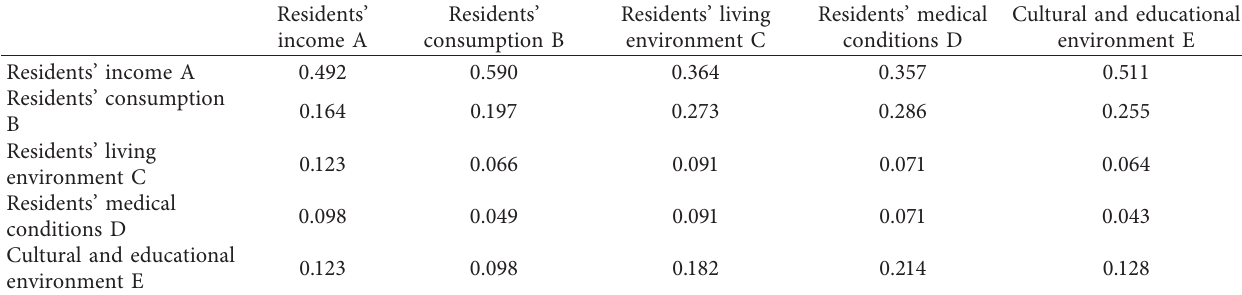
Table 5: Pairwise judgment matrix normalization.